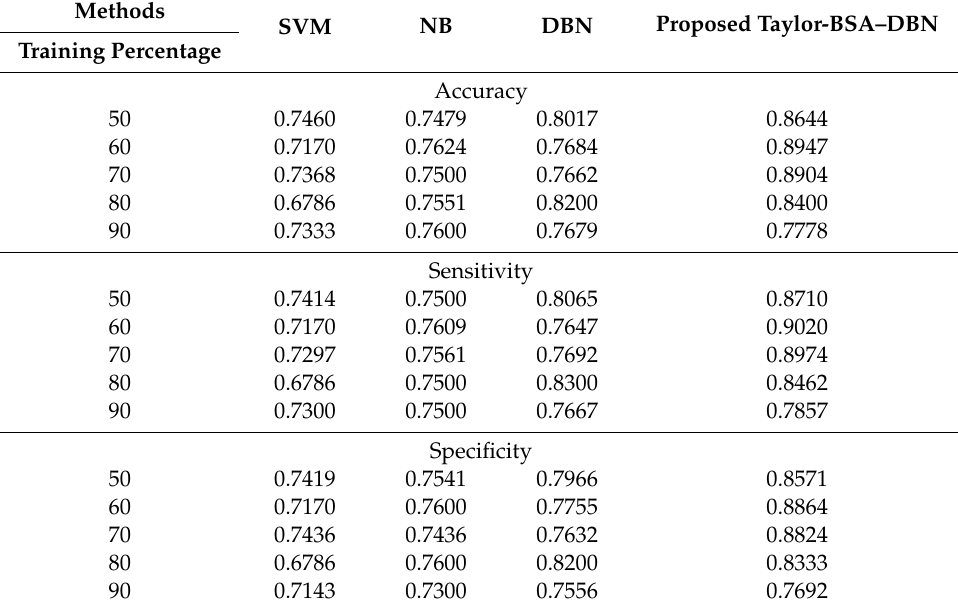
Table 7. Analysis of methods with cluster size = 9 using the Switzerland